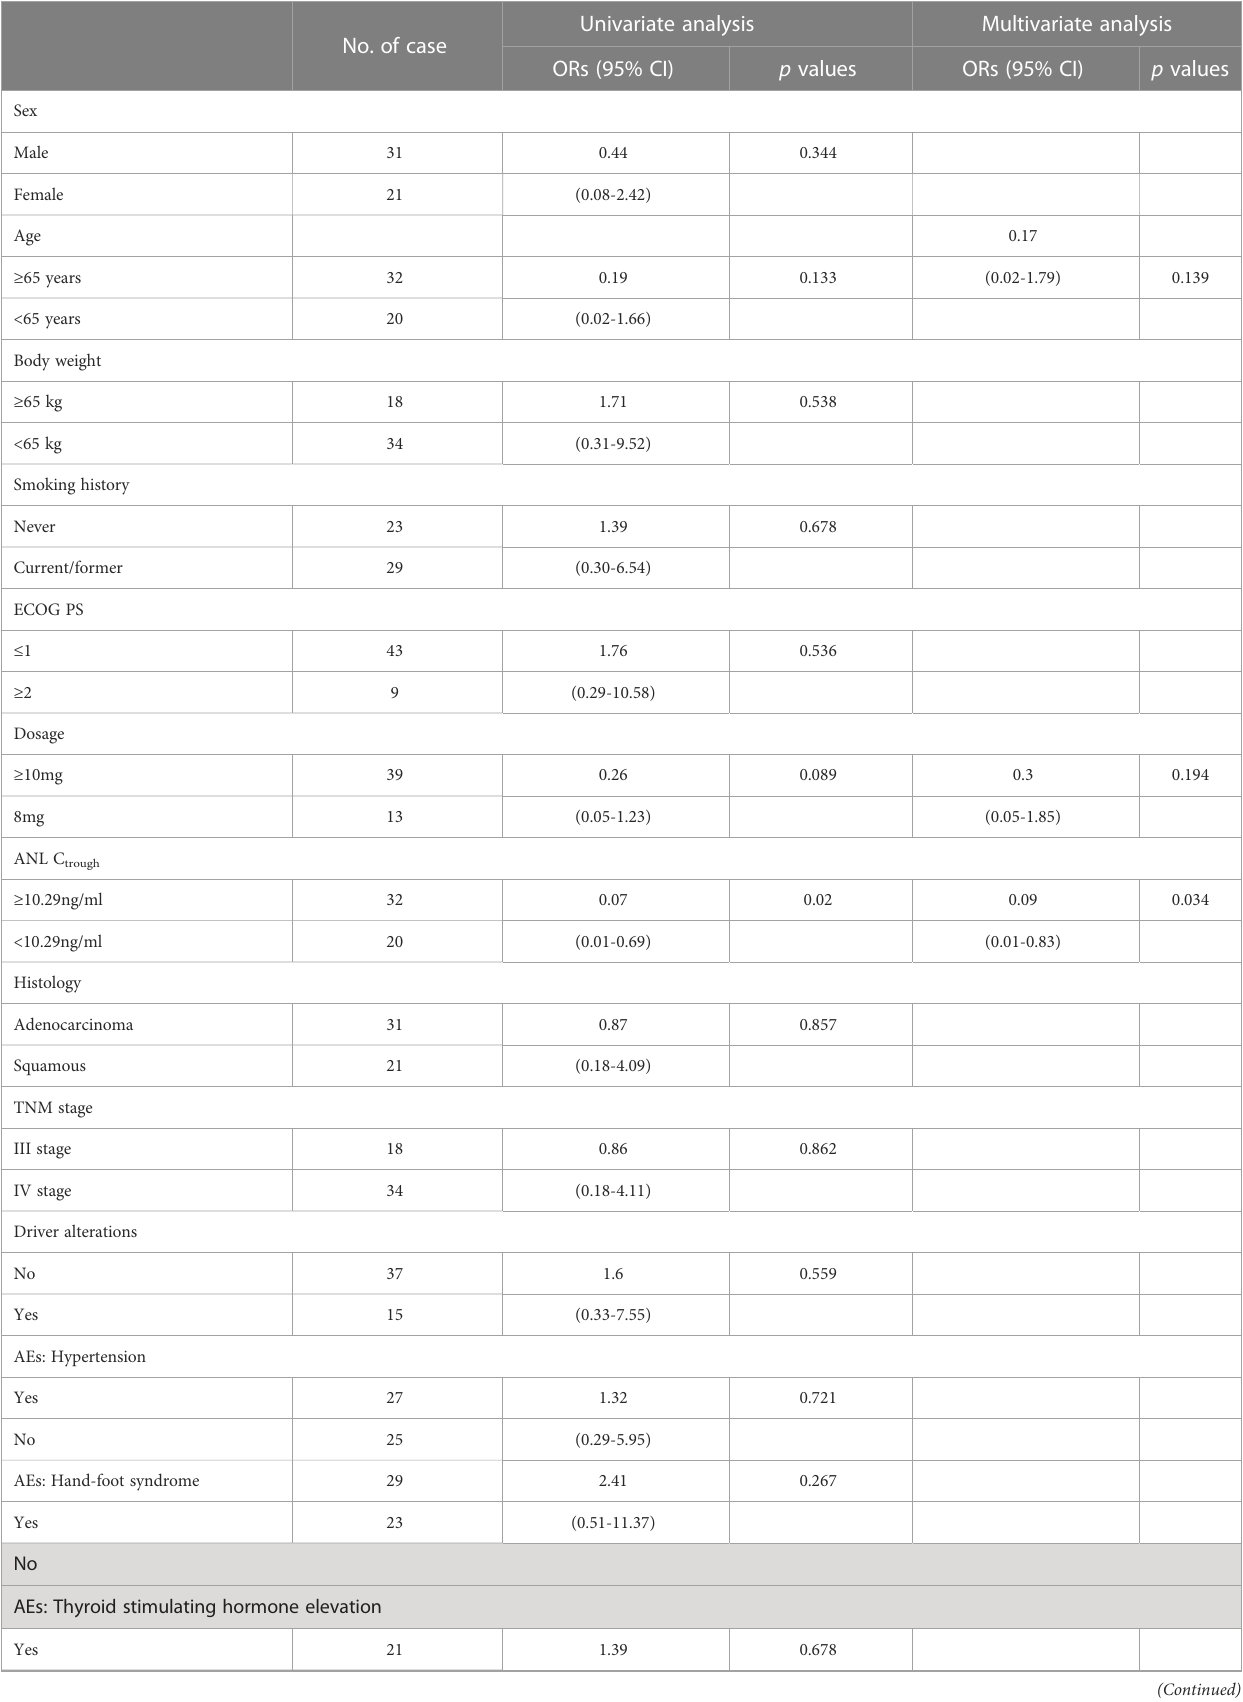
TABLE 3 Univariate and multivariate analyses of potential factors associated with disease control